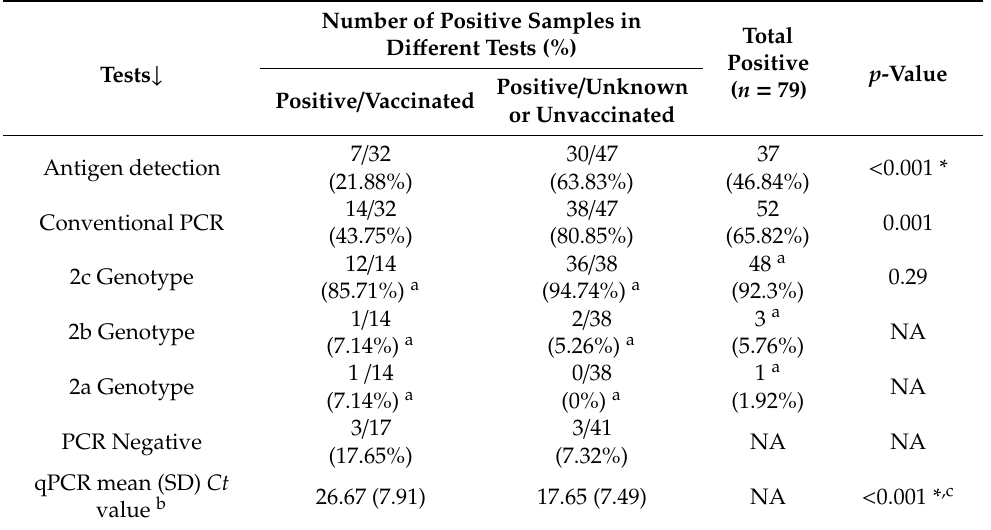
Table 2. Summary of faecal sample testing results from antigen detection, conventional PCR, genotyping sequence analysis, and qPCR tests and their distribution in vaccinated and unvaccinated / unknown vaccination status